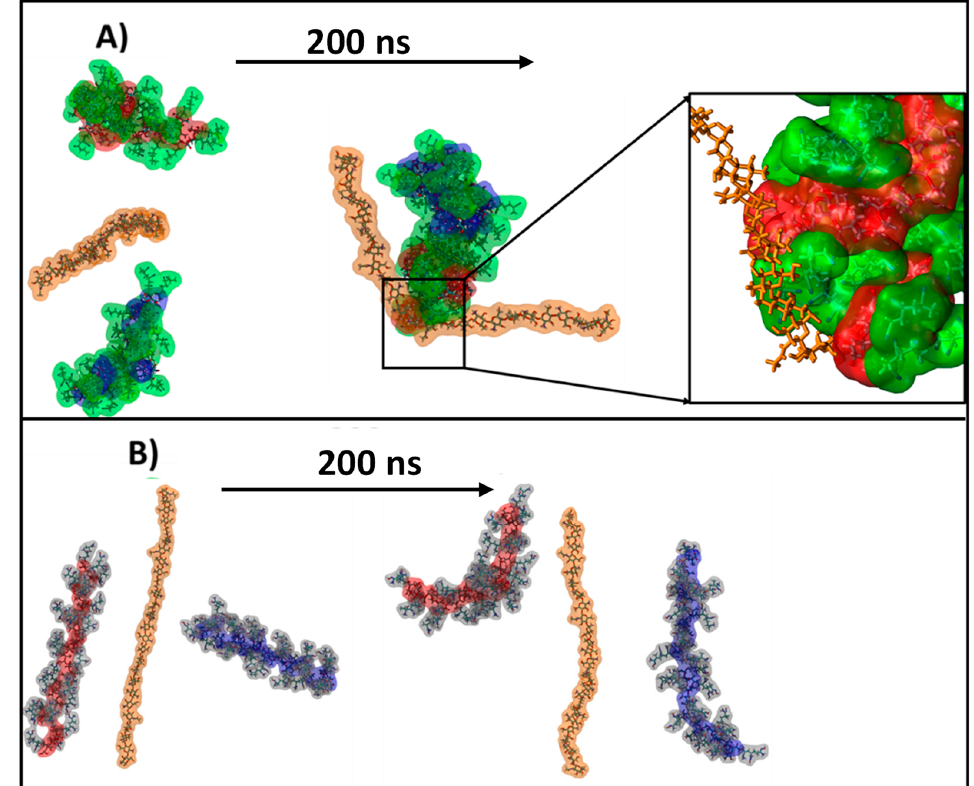
Figure 4. Snapshots depicting the starting and final structure of the simulated systems containing CS and ( A ) SgAN and ( B ) SgAx. The starch molecules are colored in red and blue, the AN side chains are colored in green, the Ax side chains are colored in silver and the chitosan is colored in orange. Water has been omitted for clarity. Table 2. The C/N and C/O atomic ratios calculated and determined by EDAX for composite